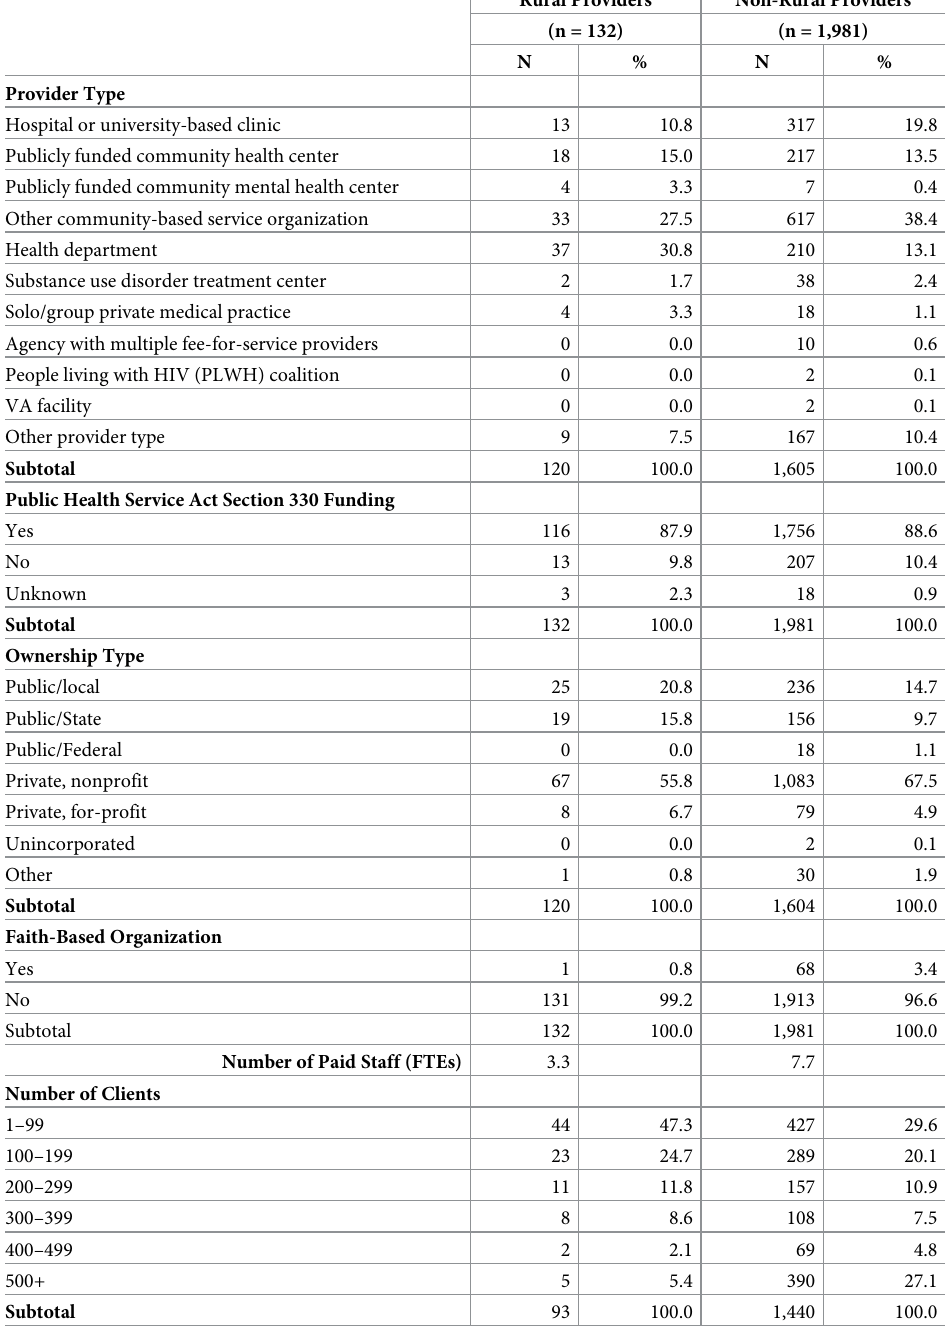
Table 2. Characteristics of rural and non-rural HRSA RWHAP providers,